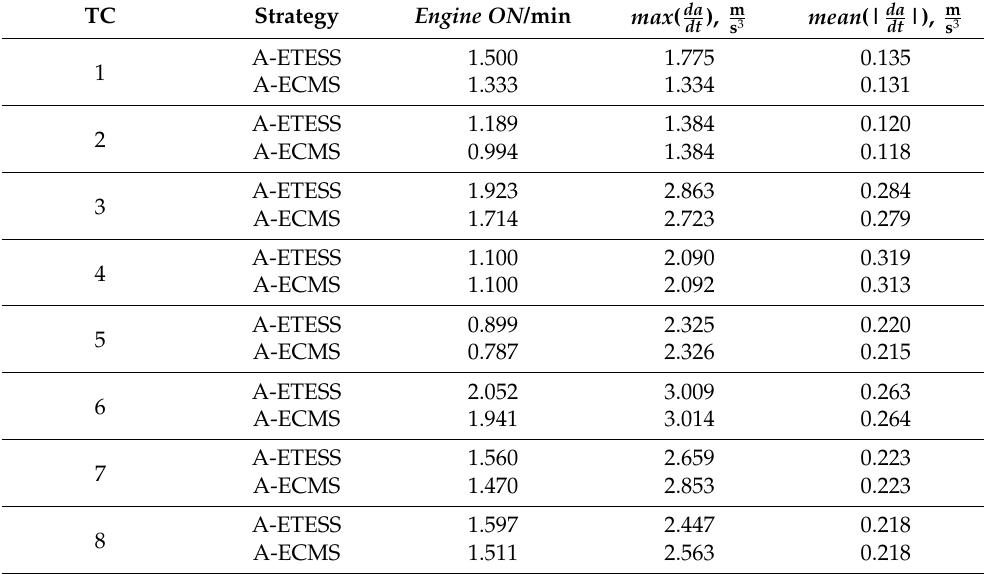
Table 3. Number of engine ON per minute and maximum and mean of vehicle acceleration derivative for the test cases of Table 2.